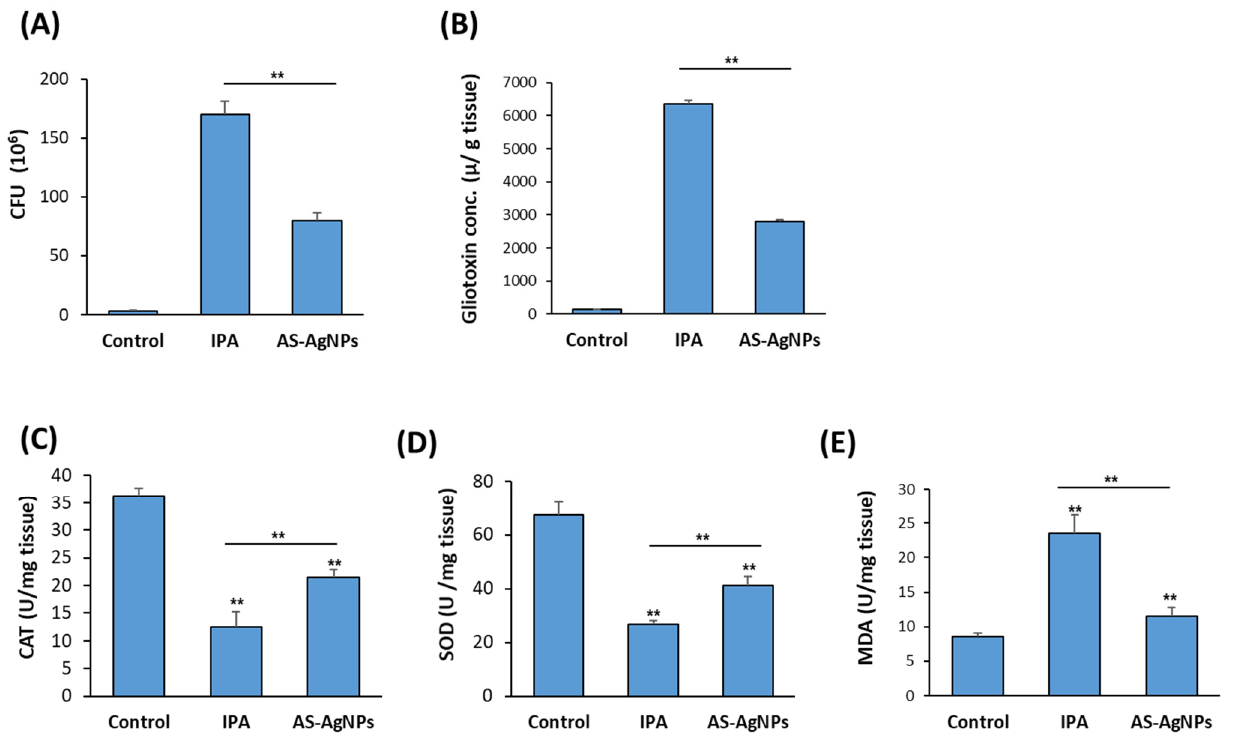
Figure 6. Effect of AS-AgNPs on lung fungal load, gliotoxin production, oxidative stress, and inflammation in IPA mice. Effect of AS-AgNPs on fungal load in lung homogenate of IPA mice ( A ). ( B ) Lung gliotoxin concentration in IPA mice treated with AS-AgNPs. The effect AS-AgNPs on the production of antioxidant enzymes ( C ) CAT, ( D ) SOD, and ( E ) MDA in the lung of IPA mice at 3 days post-instillation. Values are expressed as means ± SD ( n = 8 mice/group). * p < 0.05 and ** p < 0.005 compared to control, non-treated mice.